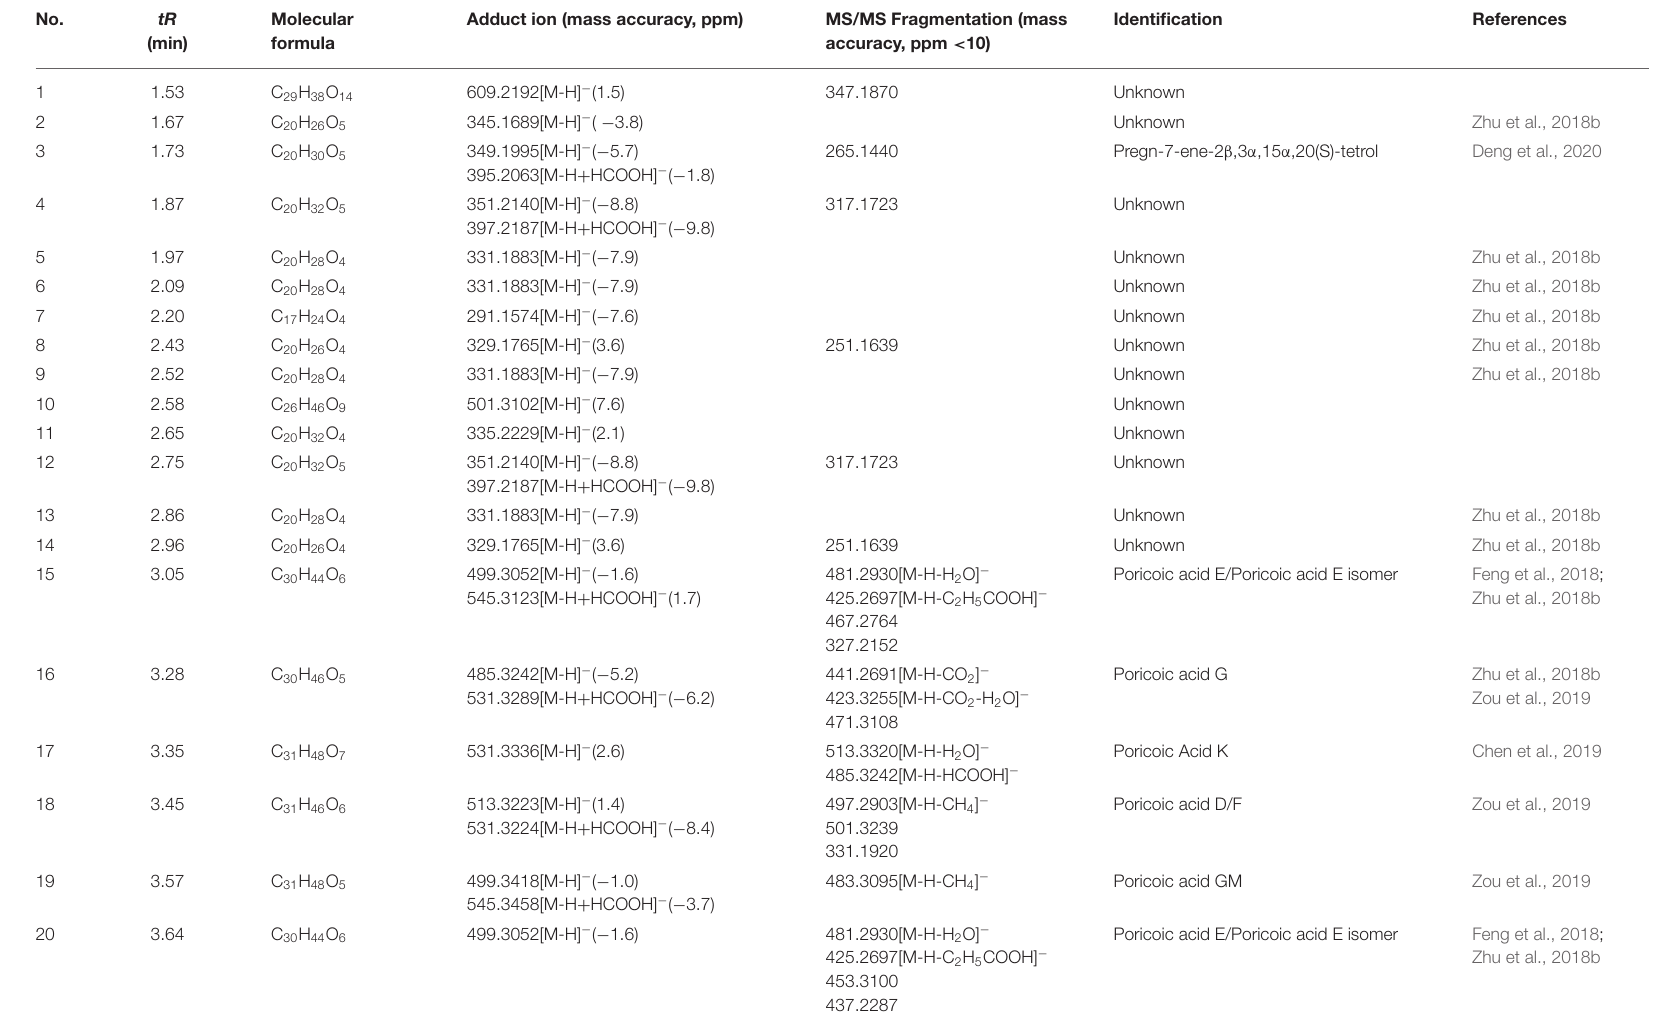
TABLE 1 | Characterization of the specialized metabolites in Fushen using UPLC-Q/TOF-MS in ESI − .